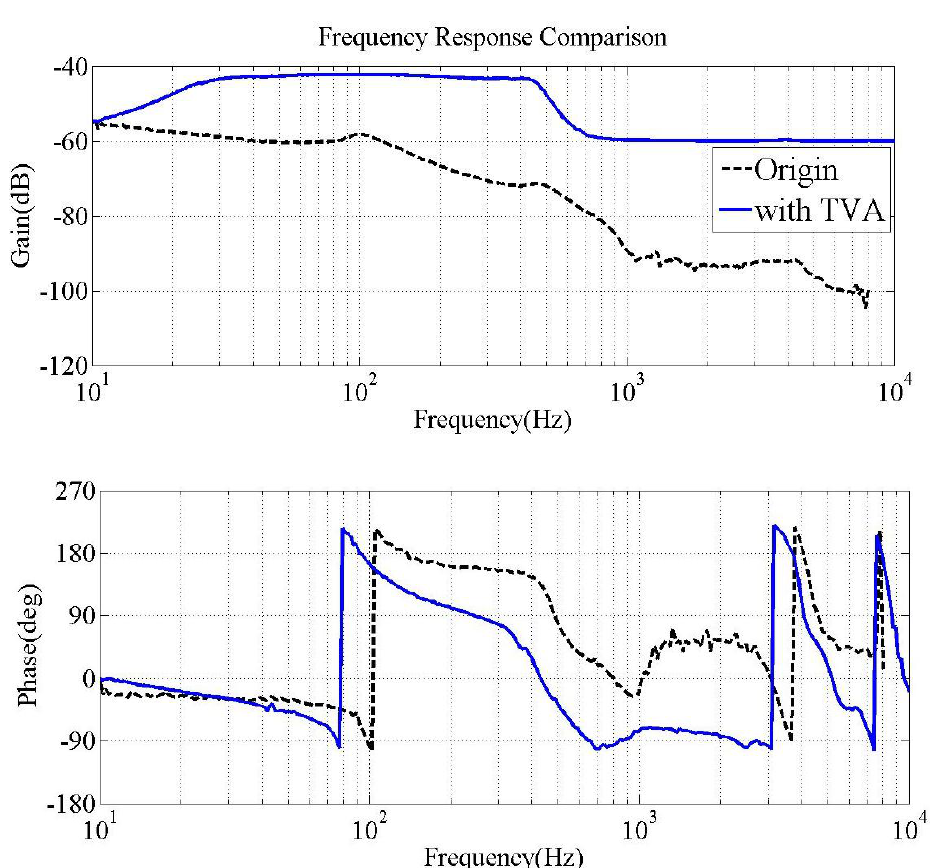
Figure 16. Frequency responses of actuator assemblies with (solid line) and without (dashed line) TVA